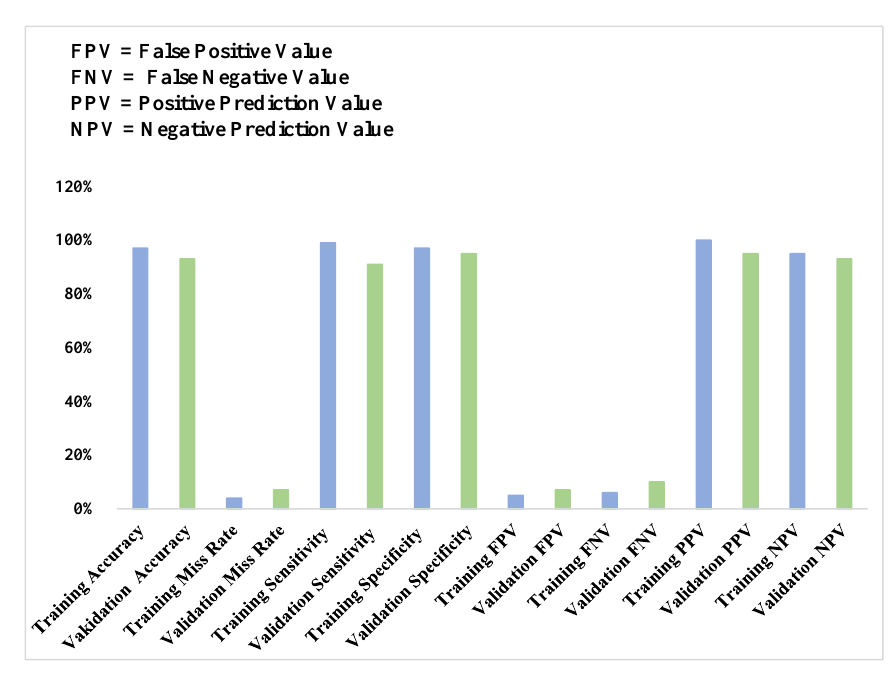
Figure 10. Performance evaluation of prediction comparison in proposed algorithms.